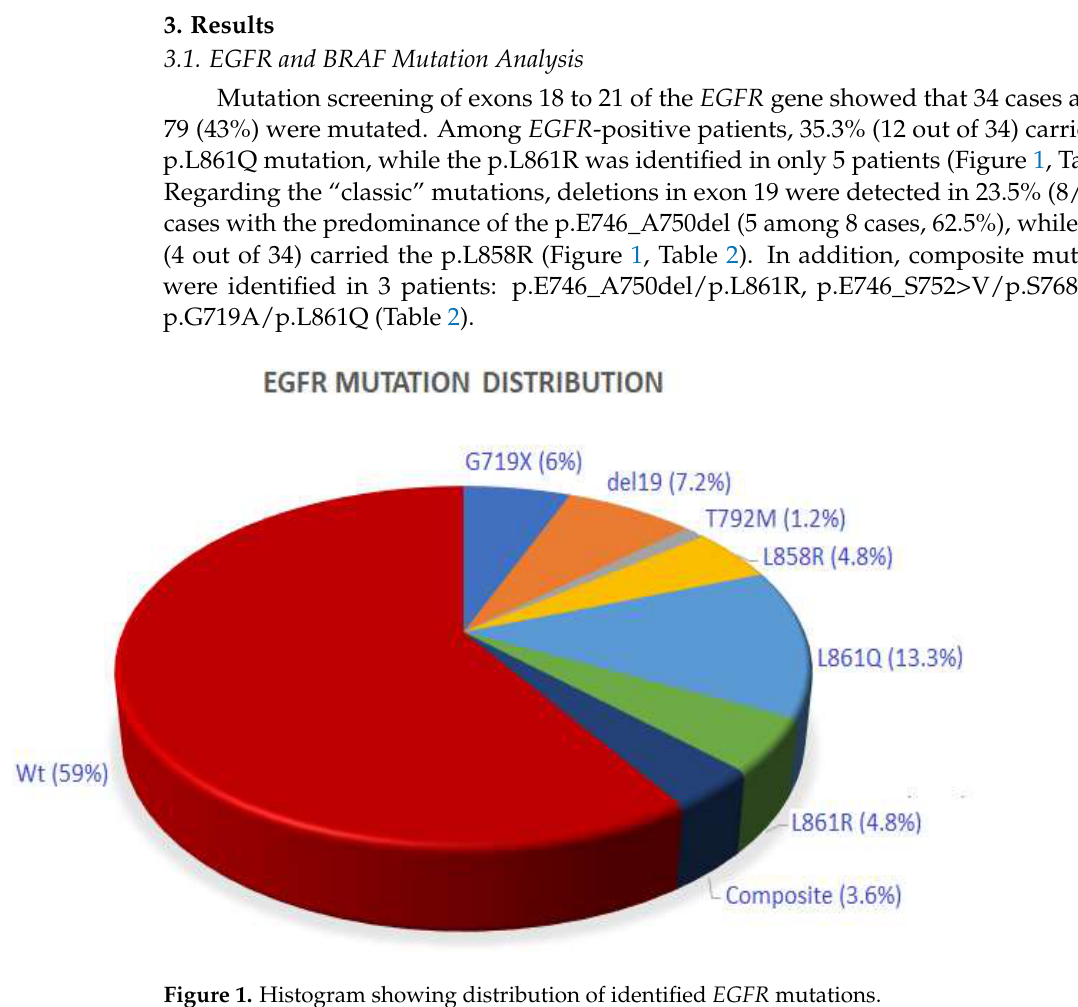
Figure 1. Histogram showing distribution of identified EGFR mutations. Table 2. Identified mutation in exons 18–21 of the EGFR in Tunisian NSCLC patients. *: Deceased before starting the target